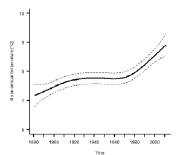
Figure 1. Mean annual temperature in southern Germany between 1881 and 2011. Solid line – regression spline fit from the GAM; dashed lines – 95% confidence intervals.